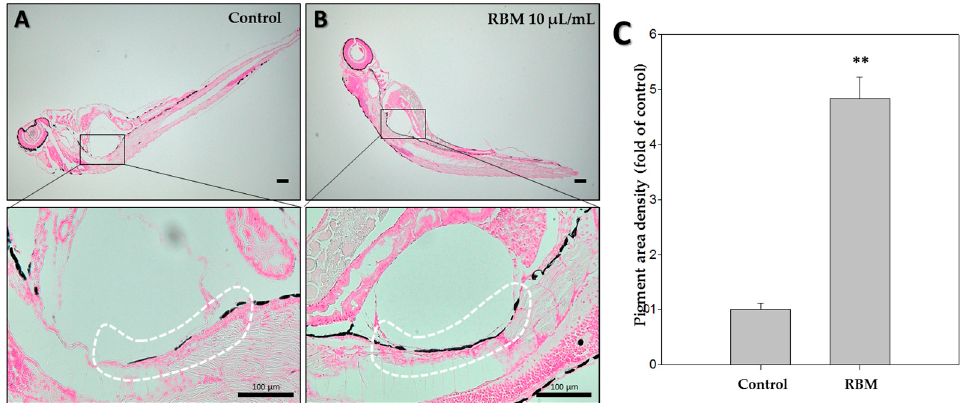
Figure 4. Effects of rice bran ash mineral extract (RBM) on zebrafish at 5dpf. Representative images of Fontana-Masson-stained zebrafish (dark color indicates secreted melanin). ( A ) Control; ( B ) RBM; ( C ) The pigmented area density in (A) and (B) was normalized to that of the control using ImageJ software. ** p < 0.05, compared to control. Original magnification: ×40 and ×100; scale bar, 100 µm.